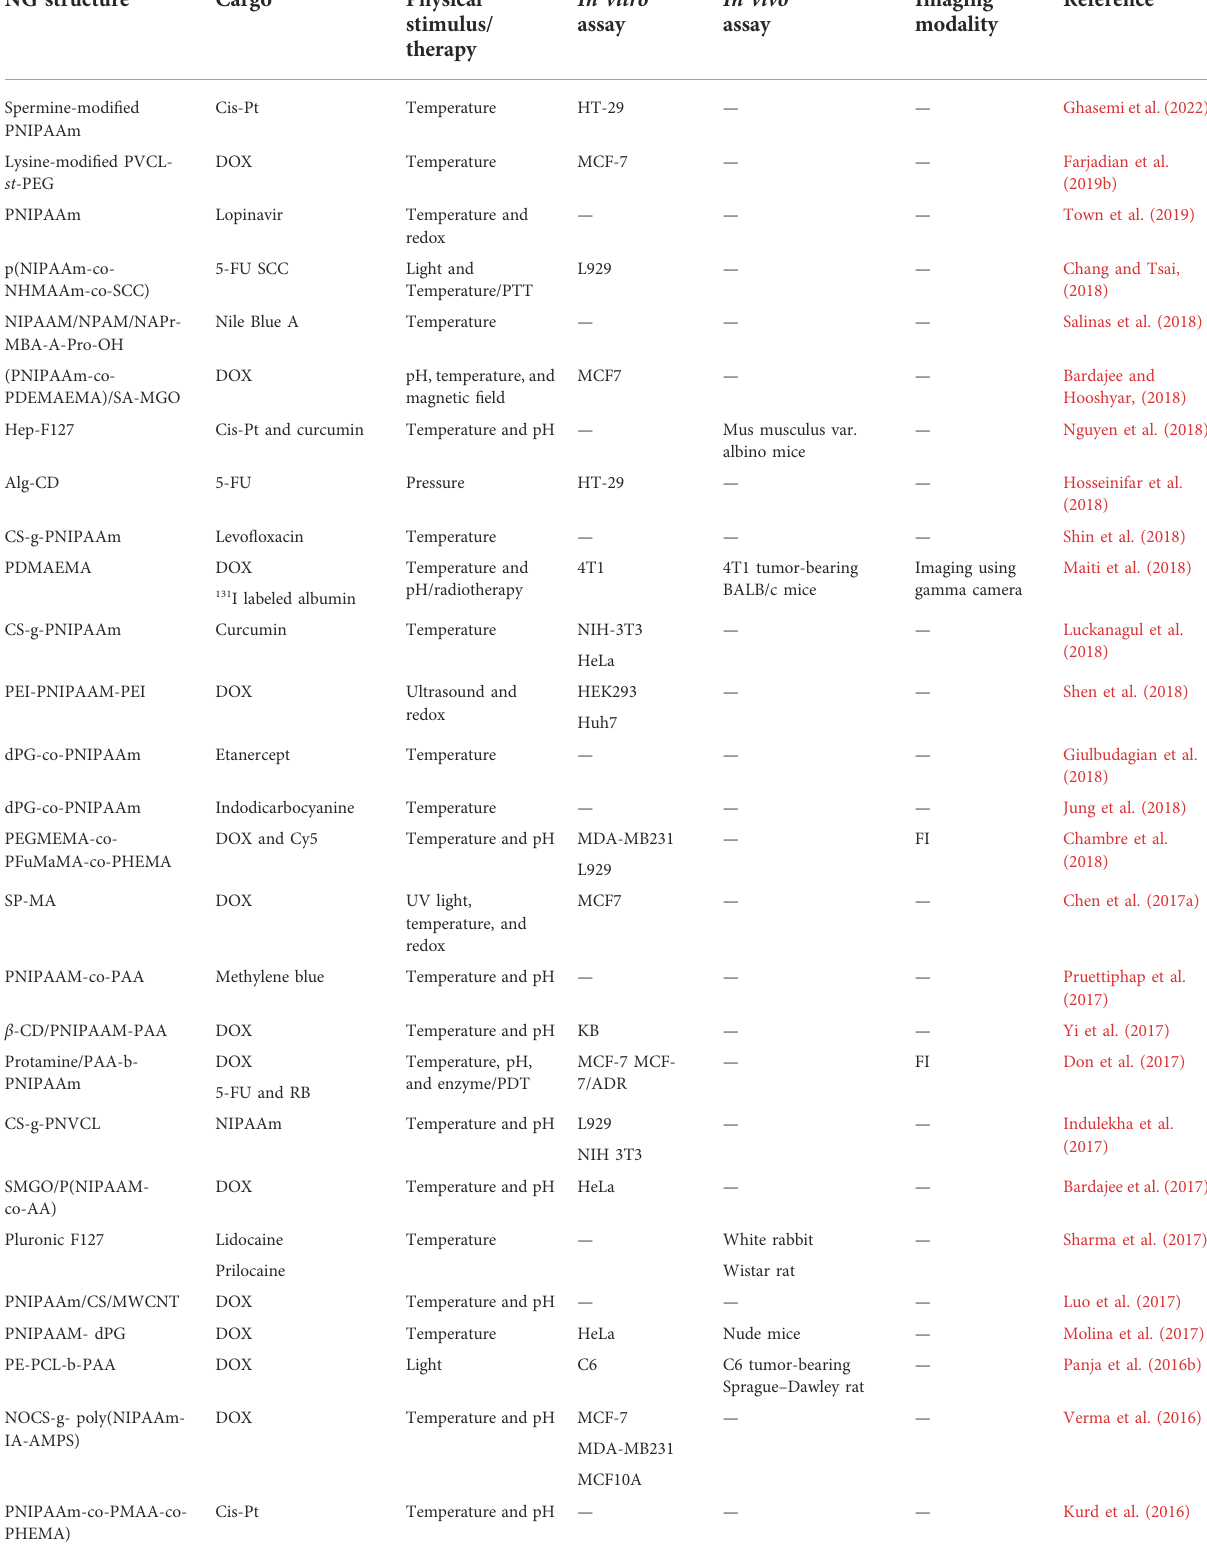
TABLE 2 Physically triggered NGs concerning the type of stimulus and cargo for in vitro and in vivo investigation, therapy, and